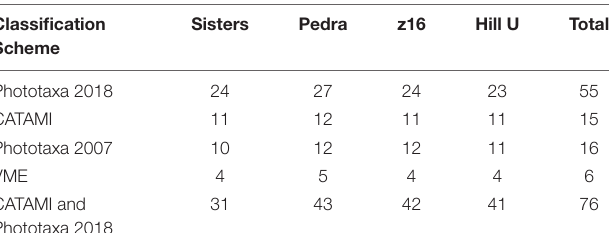
TABLE 4 | Coral entity richness by seamount and classification scheme calculated in a cumulative area of 2 140 m 2 , the area of imagery viewed on the smallest seamount,